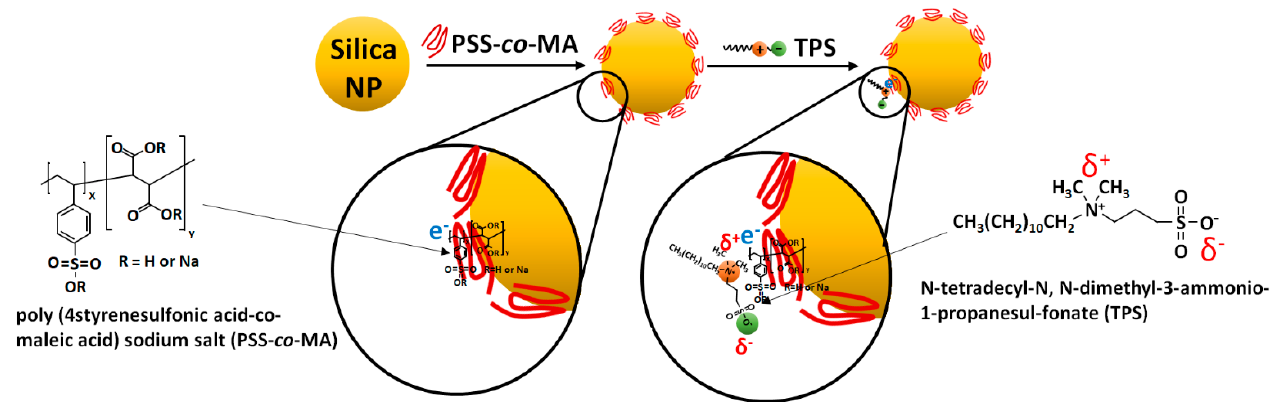
Figure 4. Schematic diagram of adsorption of zwitterionic surfactant onto negatively charged silica nanoparticle with PSS- co -MA.